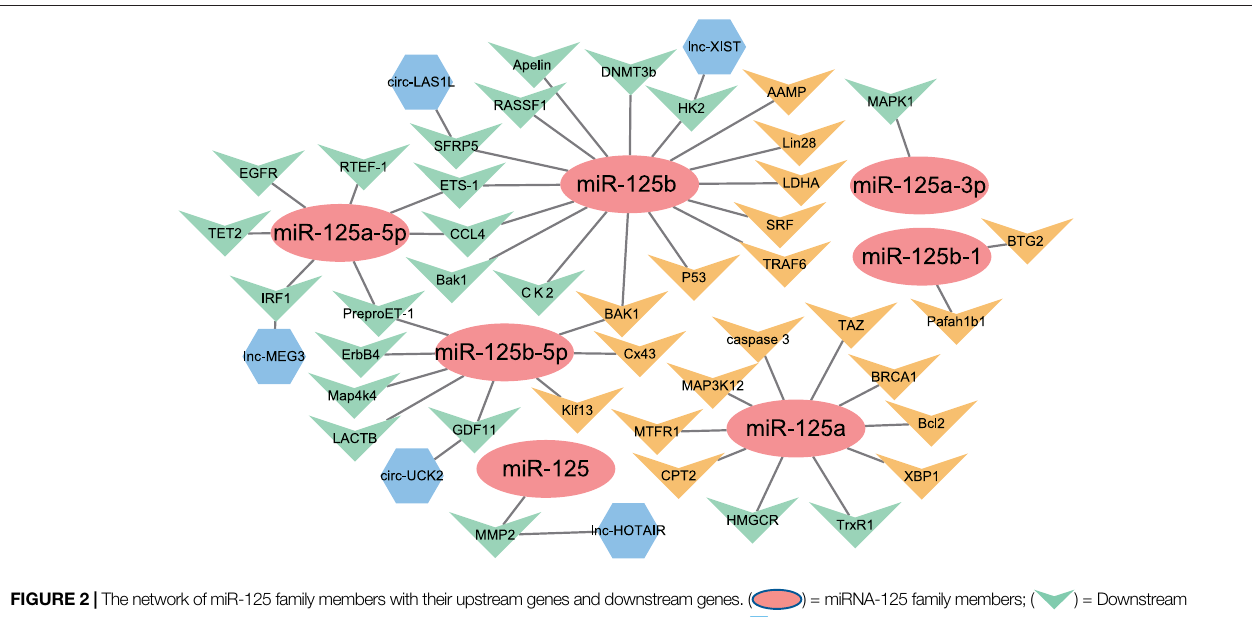
FIGURE 2 | Thenetwork ofmiR-125 family members with their upstream genes and downstream genes. ( target genes veri fi ed by luciferase assay;